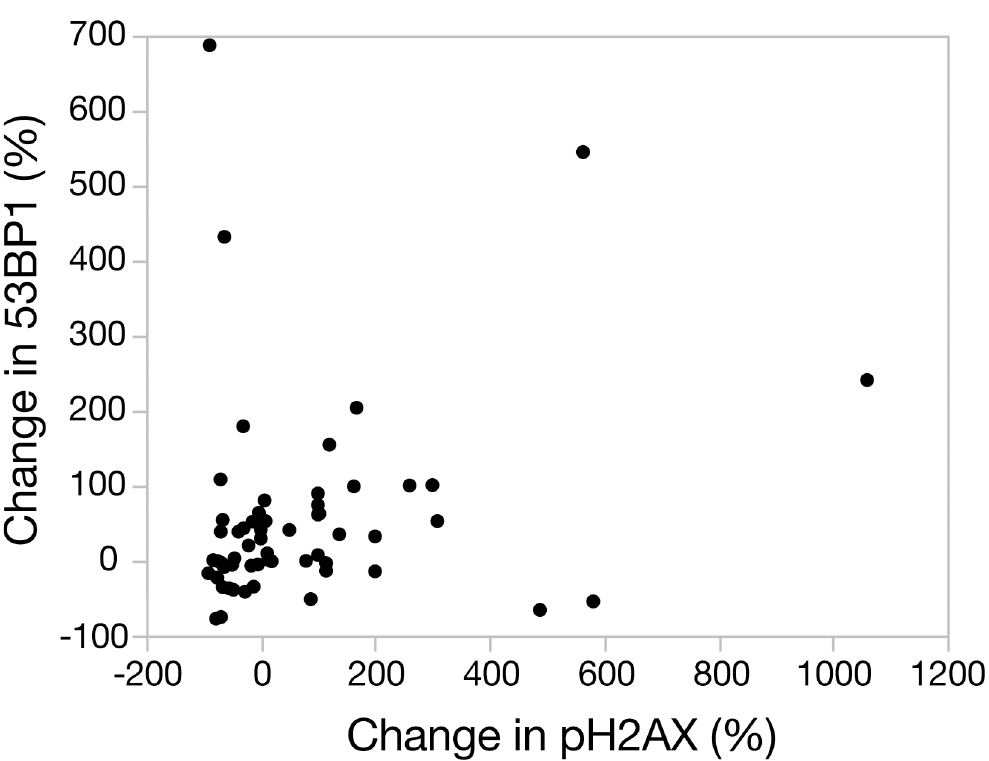
Fig 2. Correlation between relative changes in γ H2AXand 53BP1 within